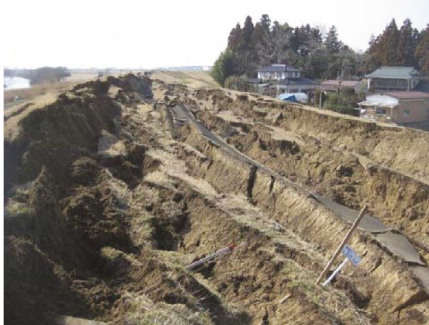
Figure 2: Damaged river embankment at Shimonakanome upper stream of Naruse River